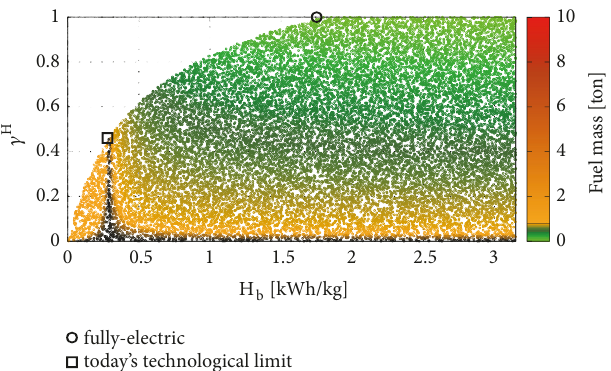
Figure 9: Parametric analysis of fuel mass consumption as function of degree of hybridisation and battery specific energy technology in comparison with iso-fuel solutions (black area) for the configuration characterised by mission requirements of 50-pax and a range of 100 nmi.